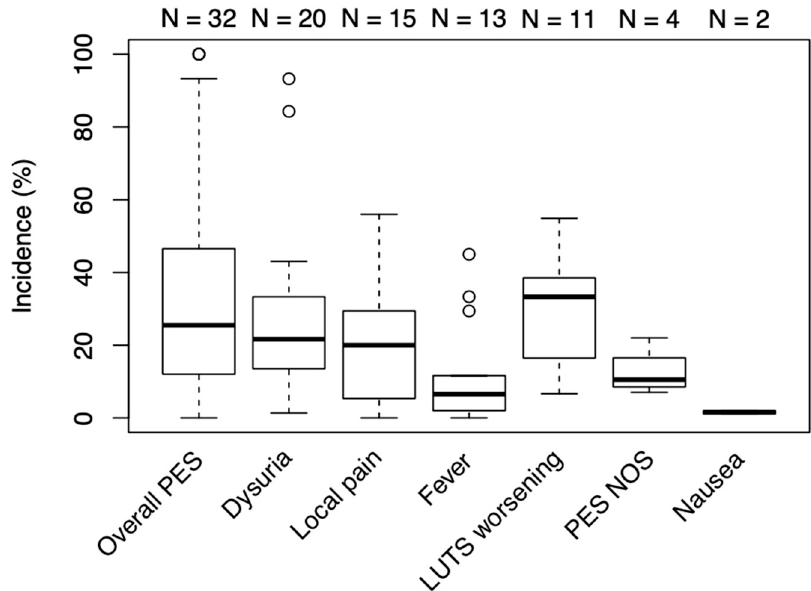
Figure 2. Median frequency of PES and its components. Box = 25th and 75th percentiles; bars = minimum and maximum values (1.5× IQR); bold line = median; N = number of studies included; outliers represented as circles. LUTS, lower urinary tract symptoms; PES, postembolization syndrome; NOS, not otherwise specified.